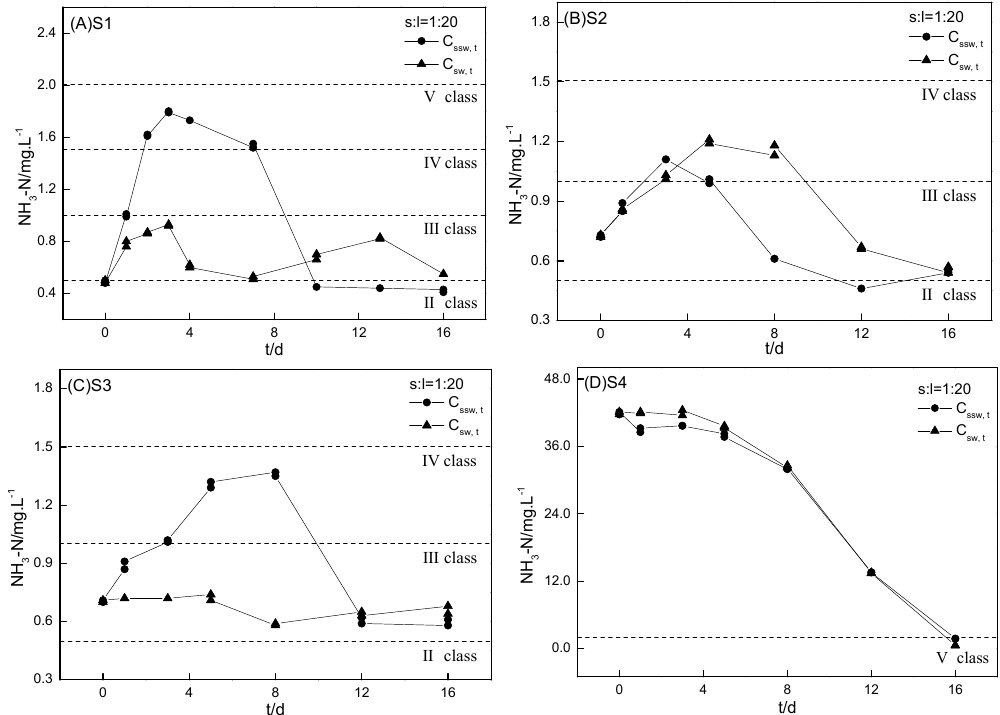
Figure 5. Kinetics of ammonium for four sediments (S1–S4) incubation in sample water ( C ssw, t ). The sediment-to-water ratio was 1:20 for the four sediments. The controls were the kinetics of ammonium incubation in sample water ( C sw, t ) without sediments.